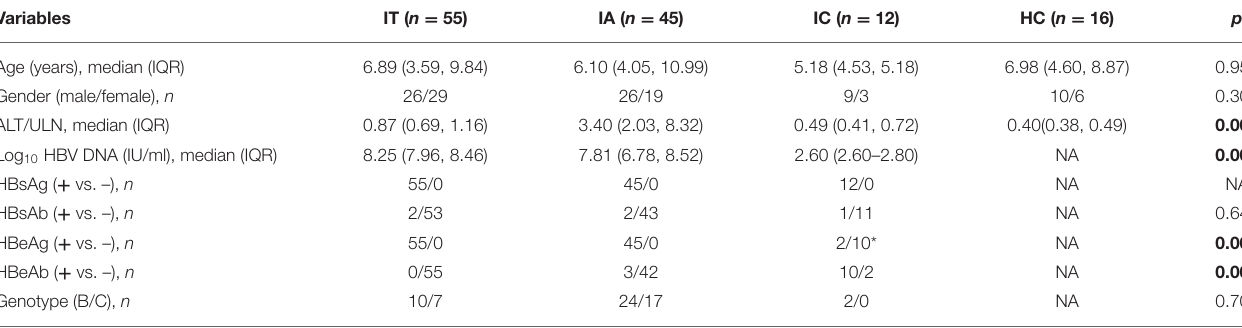
TABLE 1 | Baseline characteristics of the study population.